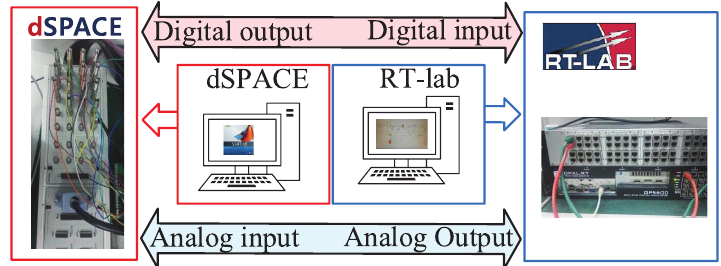
Figure 3. HIL experimental